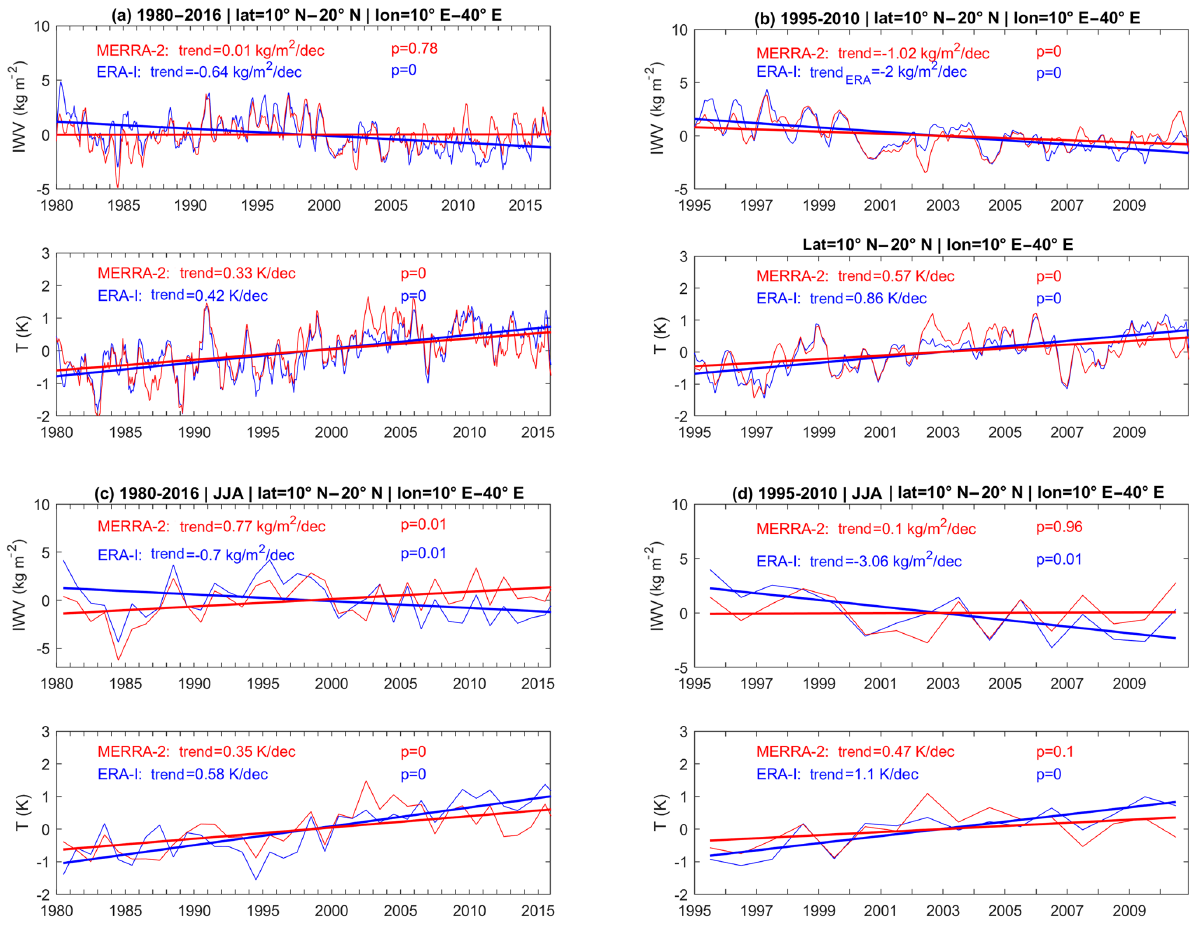
Figure 11. Temperature and IWV anomalies time series for a box over the eastern Sahel (see Fig. 12), using ERA-Interim (blue) and MERRA-2 (red) data, for (a, c) the 1980 to 2016 period, (b, d) the 1995 to 2010 period, and (a, b) the monthly time series and (c, d) the JJA